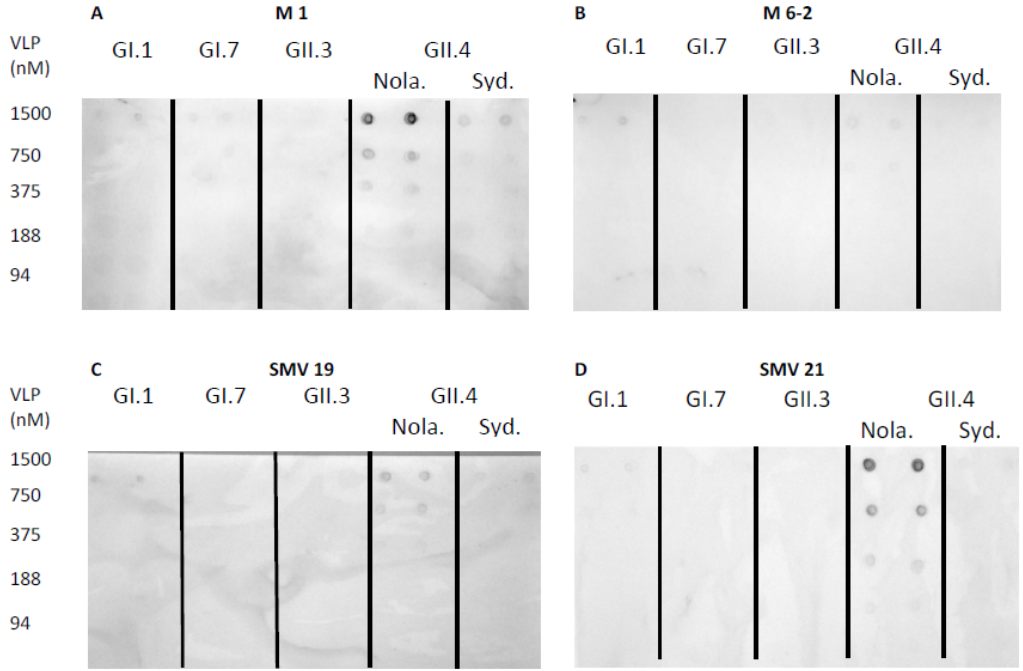
Figure 2. CD spectra of aptamer candidates M1, M6-2, SMV19, SMV21, Buf-2, AG3, and Beier (black curve) and the same biotinylated candidates (blue curve) are shown in ( A – G ), respectively.